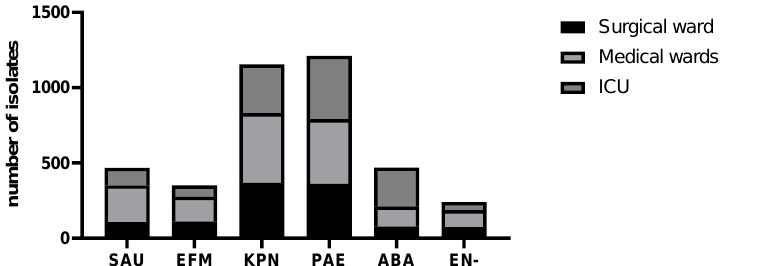
Figure 1. Distribution of ESKAPE pathogens by hospital areas. Abbreviations: SAU = Staphylococcus aureus , EFM = Enterococcus faecium , KPN = Klebsiella pneumoniae , PAE = Pseudomonas aeruginosa , ABA = Acinetobacter baumannii , EN- = Enterobacter spp. ICU = Intensive care unit